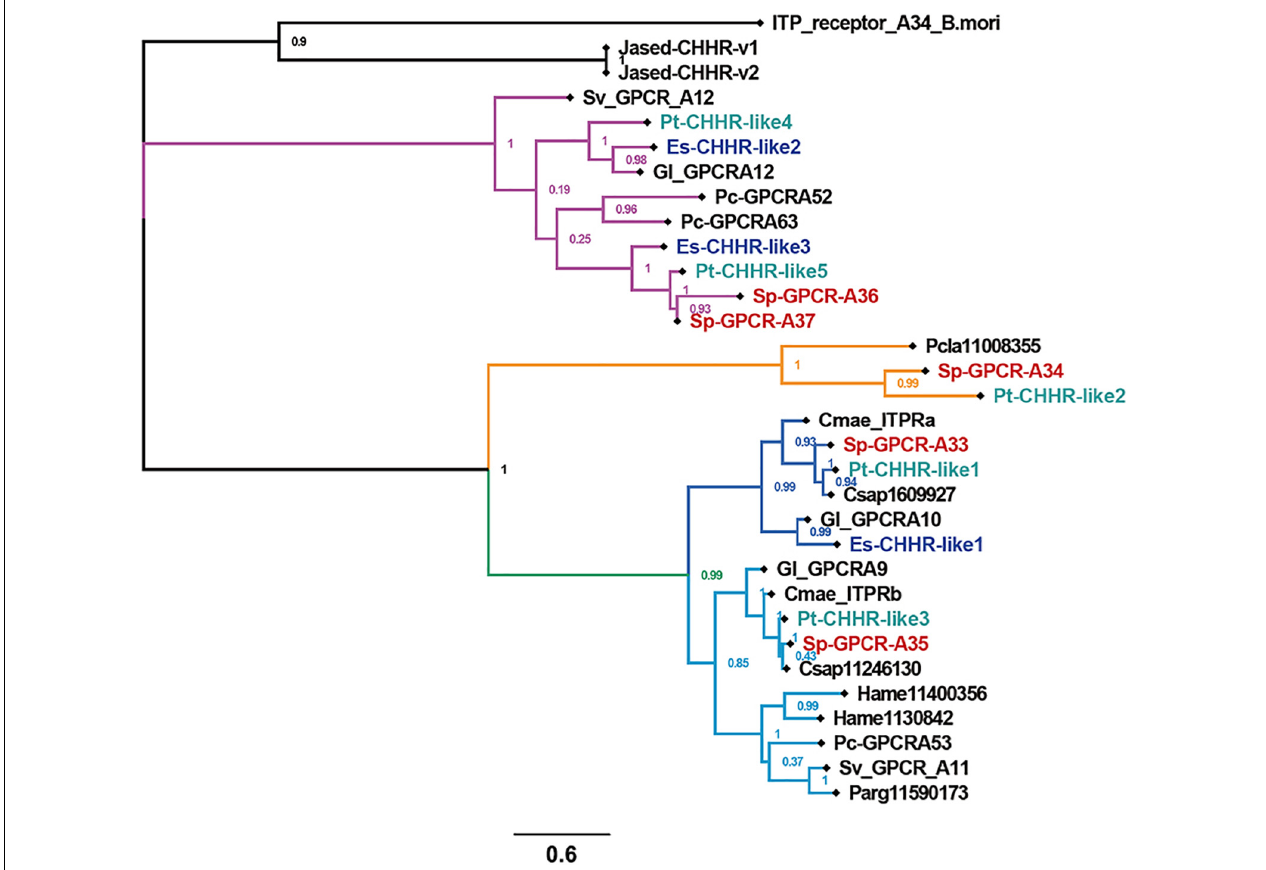
FIGURE 5 | The phylogeny of CHH GPCRs. Cladogram of putative CHH GPCRs showing connections in the clustermap of putative CHH GPCRs. Sv_GPCR, Sagmariasus verreauxi GPCR; Pc-GPCR, Procambarus clarkii GPCR; ITP_receptor_A34_B.mori, Bombyx mori ITP receptor (BNGR-A34); Gl, Gecarcinus lateralis ; Pcla, Procambarus clarkii . Cmae, Carcinus maenas ; Hame, Homarus americanus ; Csap, Callinectes sapidus ; Parg, Panulirus argus ; Jased, Jasus edwardsii .